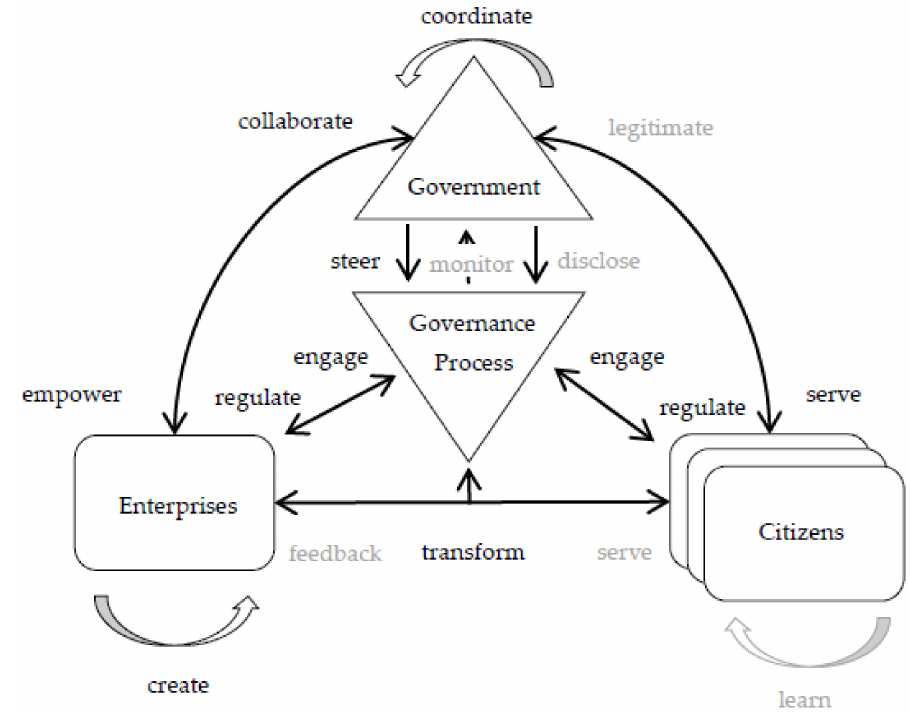
Figure 3. Framework instantiation, Guizhou-cloud big data project